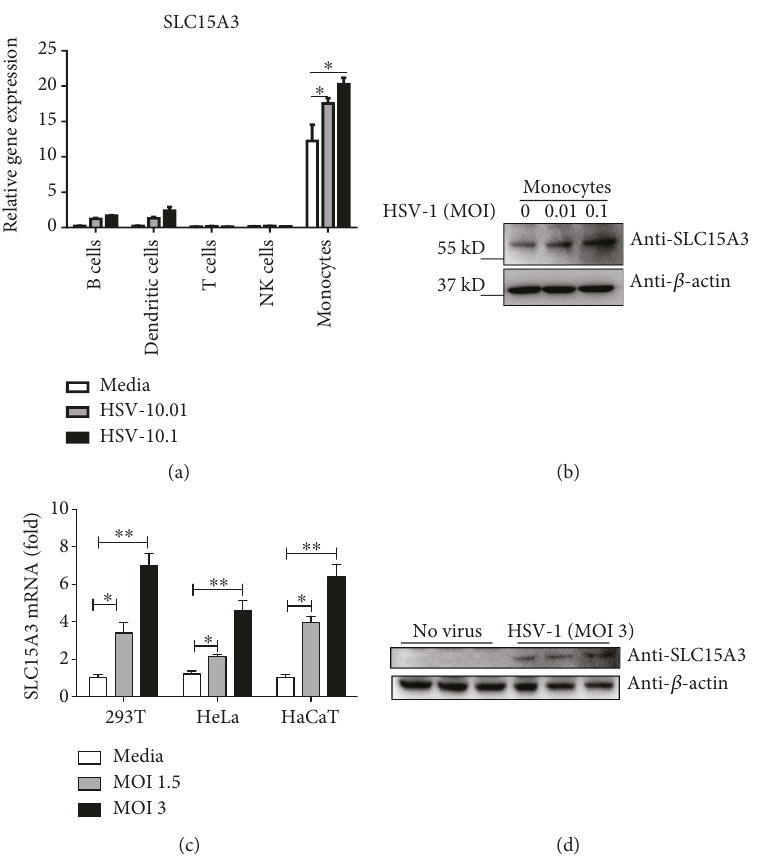
Figure 1: SLC15A3 is induced by viruses ’ stimulation in di ff erent cell types. (a) qRT-PCR analysis of SLC15A3 mRNA in di ff erent types of cells from human PBMCs ( n = 3 ) after HSV-1 stimulation for 16h at indicated MOI. (b) Western blot analysis of SLC15A3 protein in monocytes after HSV-1 stimulation for 16h at indicated MOI. (c) qRT-PCR analysis of SLC15A3 mRNA in 293T, HeLa, and HaCaT after HSV-1. (d) Western blot analysis of SLC15A3 protein after HSV-1 stimulation. ∗ P < 0 05 , ∗∗ P < 0 01 (unpaired t -test). Data are representative of three experiments with similar results (mean ± sd in (a) and